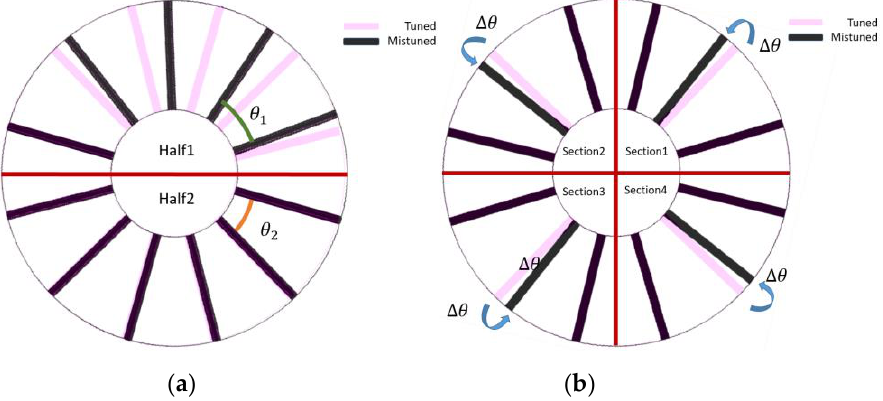
Figure 11. Two types of mistuned stators: ( a ) asymmetric mistuned stator and ( b ) sectional non- uniform mistuned stator.